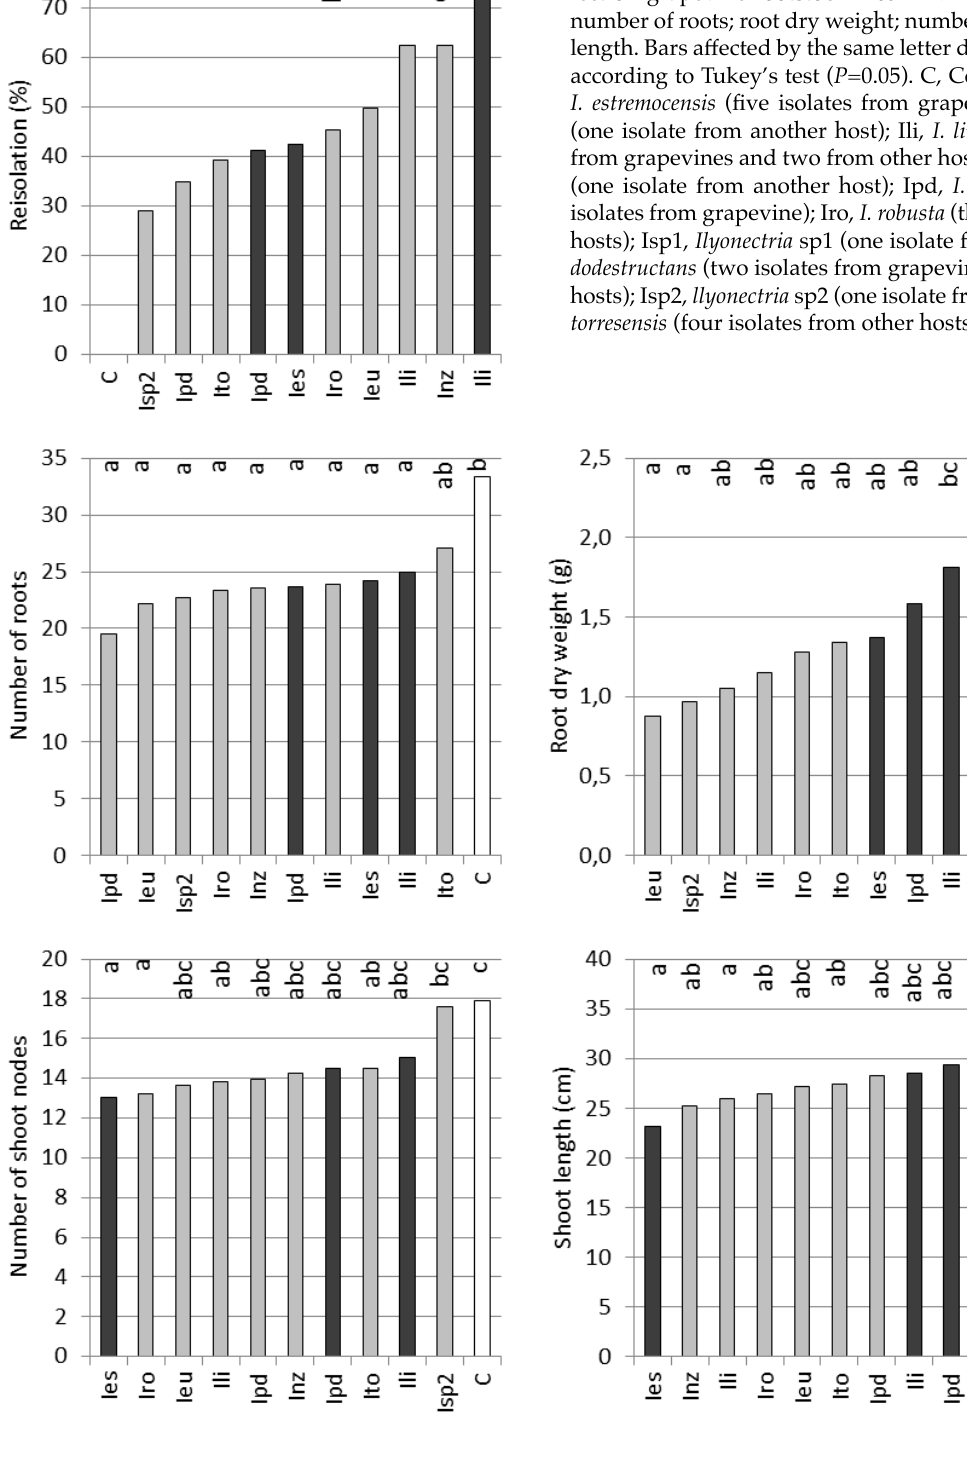
Figure 2. Comparison among Ilyonectria spp. isolates from grape- vines (black bars) and from other hosts (grey bars) for their ef- fect on grapevine rootstock 1103P in: frequency of reisolation; number of roots; root dry weight; number of shoot nodes; shoot length. Bars affected by the same letter do not differ statistically according to Tukey’s test ( P =0.05). C, Control (white bars); Ies, I. estremocensis (five isolates from grapevines); Ieu, I. europaea (one isolate from another host); Ili, I. liriodendri (three isolates from grapevines and two from other hosts); Inz, I. novozelandica (one isolate from another host); Ipd, I. pseudodestructans (two isolates from grapevine); Iro, I. robusta (three isolates from other hosts); Isp1, Ilyonectria sp1 (one isolate from olive); Ipd, I. pseu- dodestructans (two isolates from grapevines and two from other hosts); Isp2, llyonectria sp2 (one isolate from another host); Ito, I. torresensis (four isolates from other